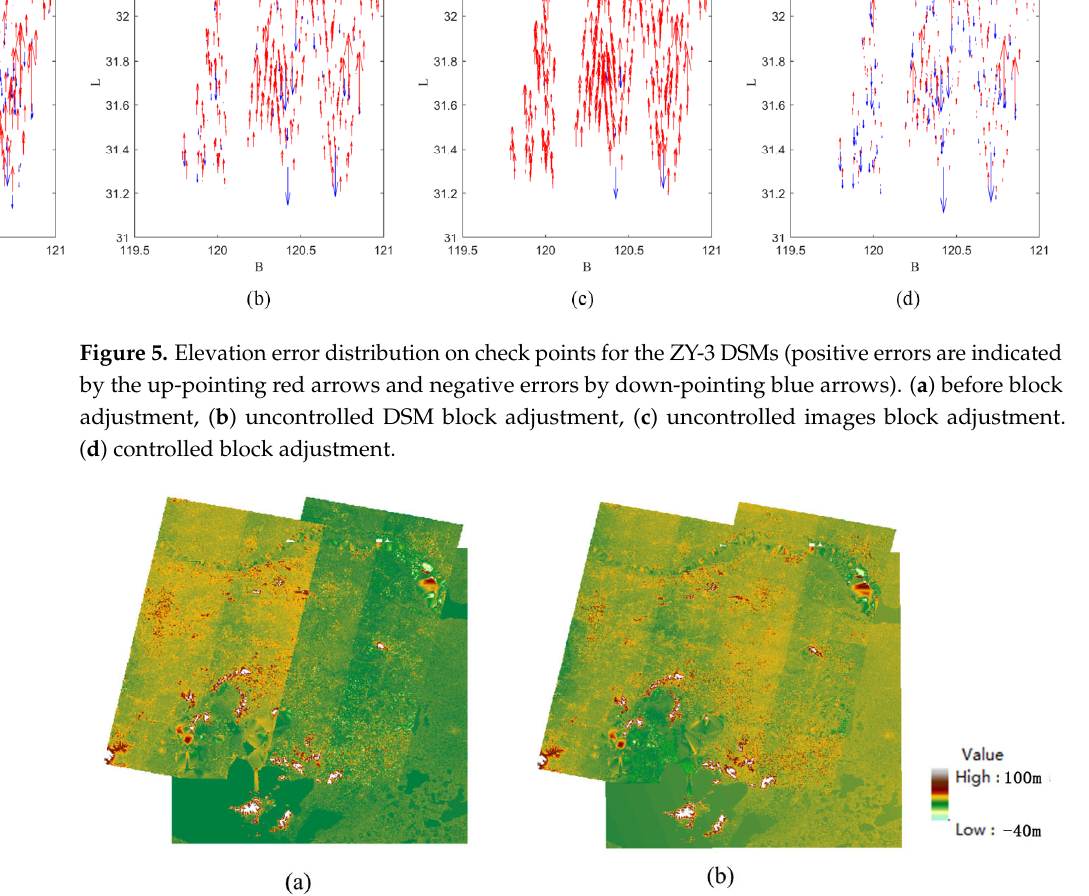
Figure 6. DSM comparison before and after the block adjustment for SRTM and ZY-3 DSM. ( a ) Be- fore block adjustment, and ( b ) after block adjustment.